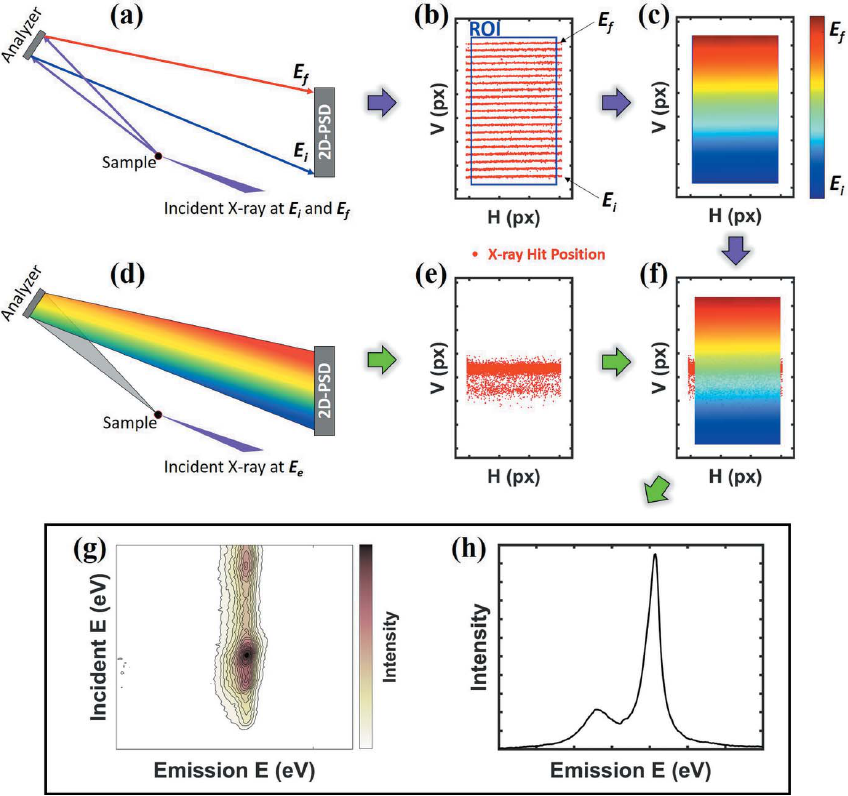
Figure 1 Workflow for obtaining a spectral form of the Mn K (cid:2) 1,3 emission of MnO. ( a ) Schematic of the optical geometry for obtaining elastically scattered X-rays with two different energies, E i (6445 eV) and E f (6540 eV). ( b ) Distribution of elastically scattered X-rays on the horizontal H (px) and vertical V (px) pixels of the 2D-PSD for an incident energy range of E i and E f at 5 eV intervals. The blue box indicates the ROI that is described in the text. ( c ) CEM corresponding to the energy distribution in the ROI of ( b ). ( d ) Schematic of the geometry used to obtain emission X-rays at a specific energy E e . ( e ) Distribution of emitted X-rays on the 2D-PSD. ( f ) Applying CEM to the distribution of ( e ). ( g ) Mn K (cid:2) 1,3 RXES and ( h ) Mn K (cid:2) 1,3 XES of